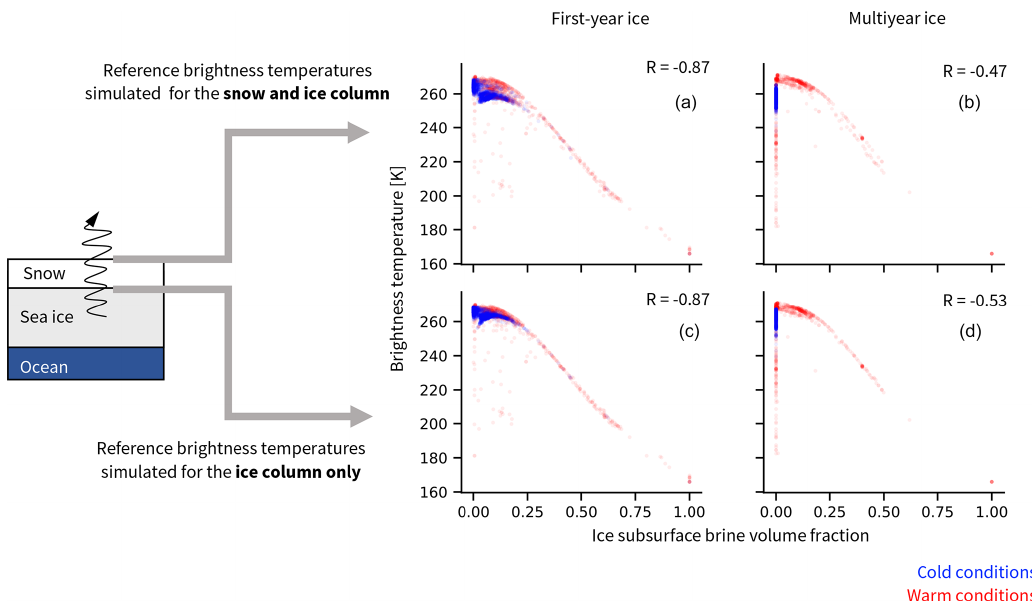
Figure 3. Reference brightness temperatures at 6.9GHz vertical polarization, simulated based on properties simulated by SAMSIM for the ice and snow column (a, b) and on the ice column only (c, d) , as a function of the reference ice subsurface brine volume fraction for first year-ice (a, c) and multiyear ice (b, d) . Blue represents cold conditions (October to March), and red represents warm conditions (April to September). R is the correlation coefficient between the brightness temperature and the ice subsurface brine volume